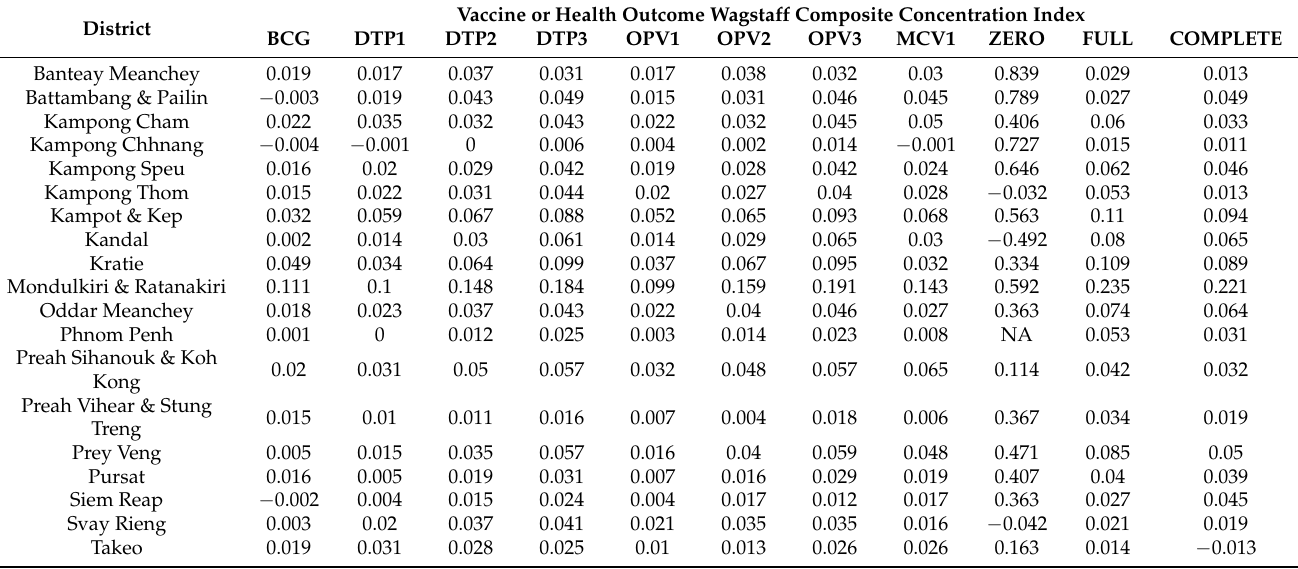
Table 3. Composite Wagstaff concentration indices for individual districts and district pairs for national immunization program vaccines and vaccination statuses for survey year